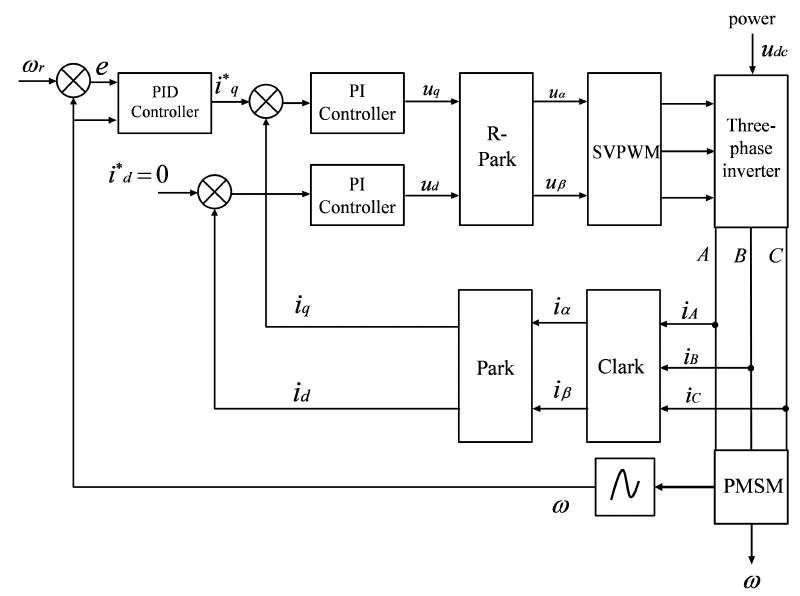
Figure 4. Vector control